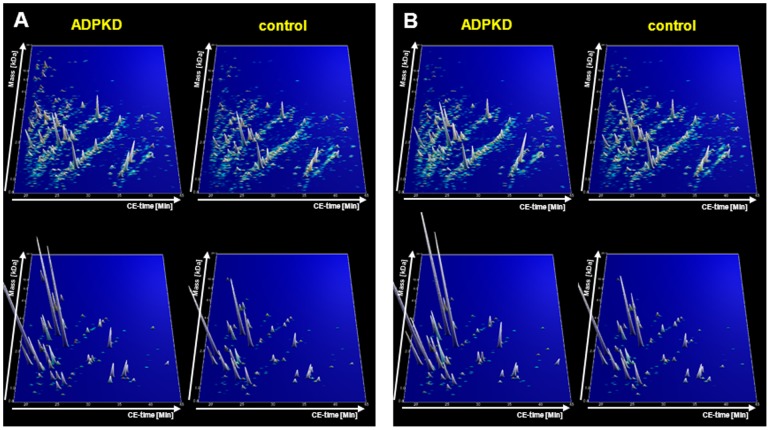
Compiled urinary protein profiles of ADPKD patients and healthy controls.Proteomic profiles for the training cohort (41 patients of the SUISSE ADPKD study vs. 189 controls, panel A) and the validation cohort (224 CRISP study samples vs. 86 controls, panel B) are depicted separately. Normalized MS molecular weight (800–20,000 Da) in logarithmic scale is plotted against normalized CE migration time (18–45 min). The mean signal intensity of polypeptides is given as peak height. In the lower panels, only the 142 biomarkers that were included in the diagnostic biomarker model are depicted, and their amplitude is shown with 5× zoom compared to the upper panels.